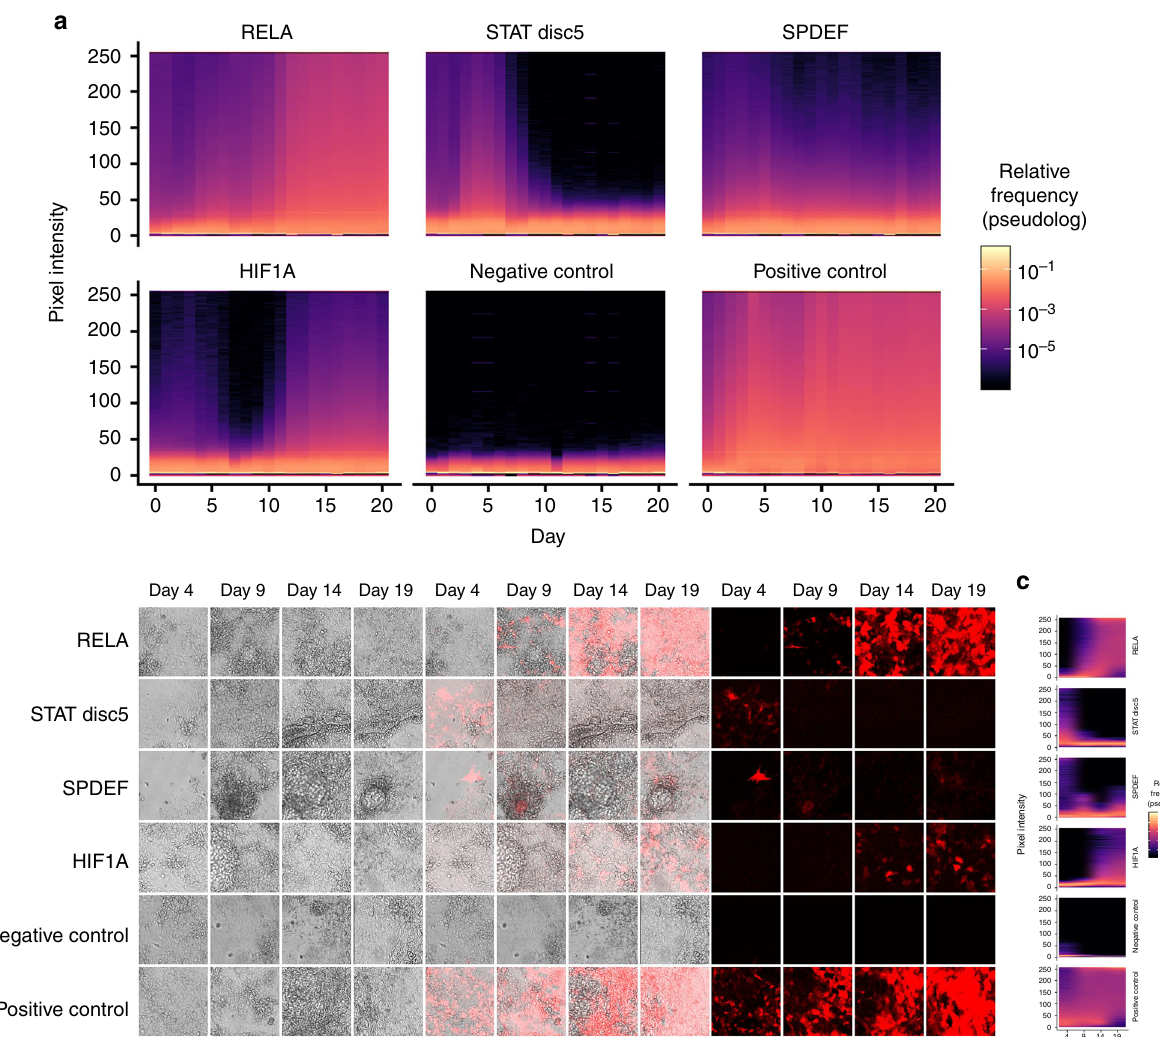
Fig. 2 Synthetic promoters exhibit distinct temporal and spatial behavior in organoid cultures derived from iPSCs. a The heat maps show distinct temporal and spatial activities of four promoters across the time course of differentiation. The X-axis denotes the days post Dox-induced differentiation. The Y-axis denotes the fl uorescence intensity as the pixel value of an 8-bit image ( fl uorescence intensity is equally divided into 256 bins, 0 being the lowest, and 255 being the highest). Heat map colors show the relative frequencies of pixel fl uorescence intensity distribution in each bin with a log pseudocount to account for absent bins [(1 + number of pixels in each fl uorescence intensity bin/number of total pixels)]. The distributions show the difference in the timing and strength of promoter activation, and the fraction of the image containing fl uorescent cells. The negative control sample consisted of cells infected with a non- fl uorescent protein; the positive control sample consisted of cells infected with a Ubiquitin C promoter expressing mKate2. b Representative fl uorescence and bright fi eld microscopy images show distinct temporal and spatial activities and differences in expression strength of the four promoters. The sub-regions exhibiting the strongest fl uorescence signal for each promoter are shown. Left panel contains the bright fi eld images (Days 4 – 19), middle panel contains the overlay images (Days 4 – 19), and right panel contains the fl uorescence images (Days 4 – 19). c The heat maps show the relative frequencies of pixel distribution in each fl uorescence bin for the representative fl uorescence microscopy images in b . N = 3 biological